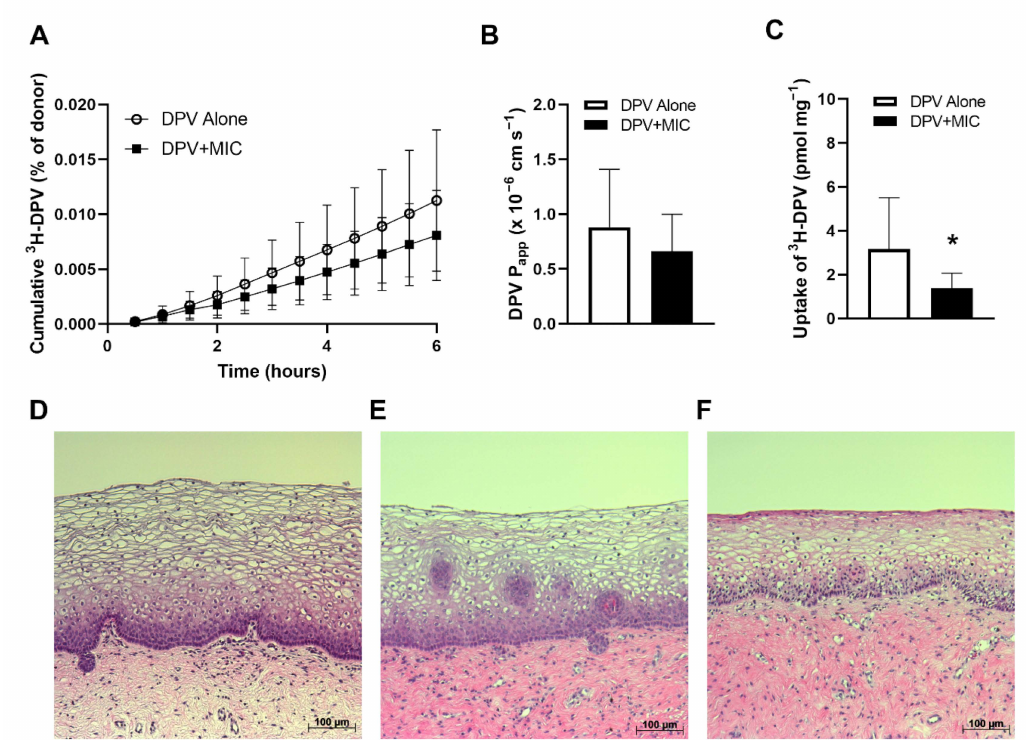
Figure 6. Linear flux of DPV across human cervical tissue ( A ), DPV P app values obtained from the tissue permeability assay ( B ), and DPV levels in human cervical tissue ( C ), * p < 0.05 compared to DPV alone (Student’s t -test); Data represented as mean ± SD with n = 10–12 replicates from 6 tissue donors; Representative histology results of pre-treated tissue ( D ), tissue post-exposure to DPV alone ( E ), and tissue post-exposure to DPV and MIC ( F